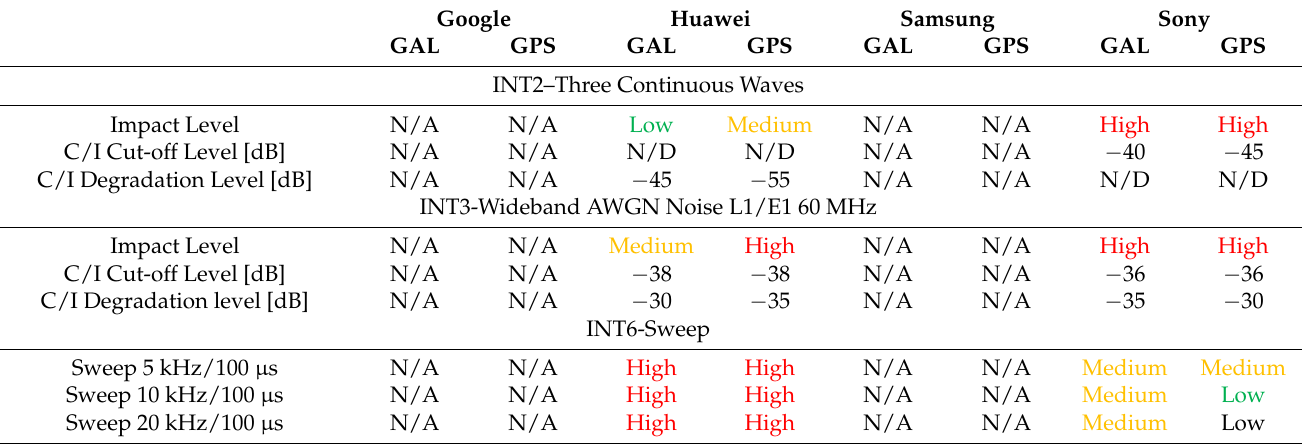
Table 3. Impact level of various interferences for dynamic jamming